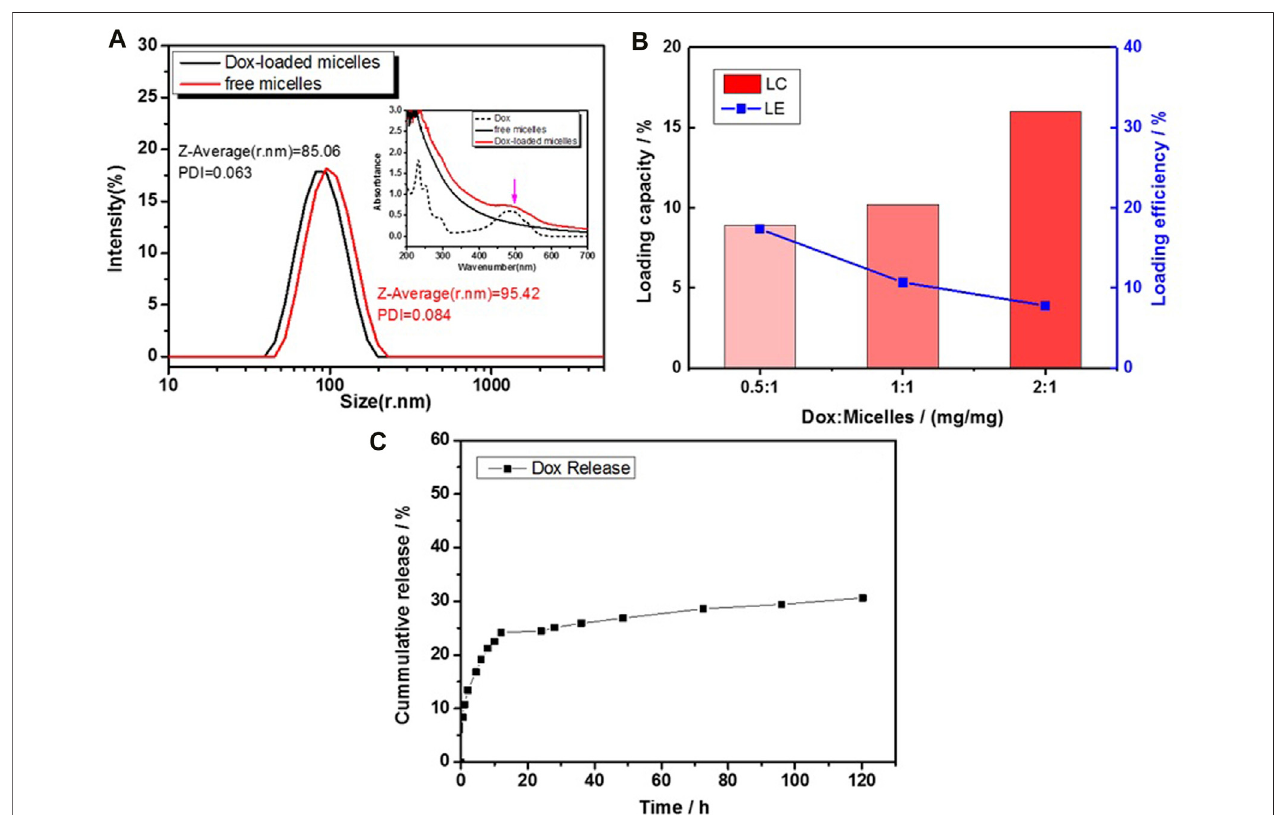
FIGURE 7 | (A) Size distribution by intensity (inset: UV-vis spectrum) for free micelles and Dox-loaded micelles; (B) drug-loading capacity and ef fi ciency of Dox- loaded micelles; and (C) release pro fi le of Dox-loaded micelles in L in PBS (0.1 M, pH 7.4).